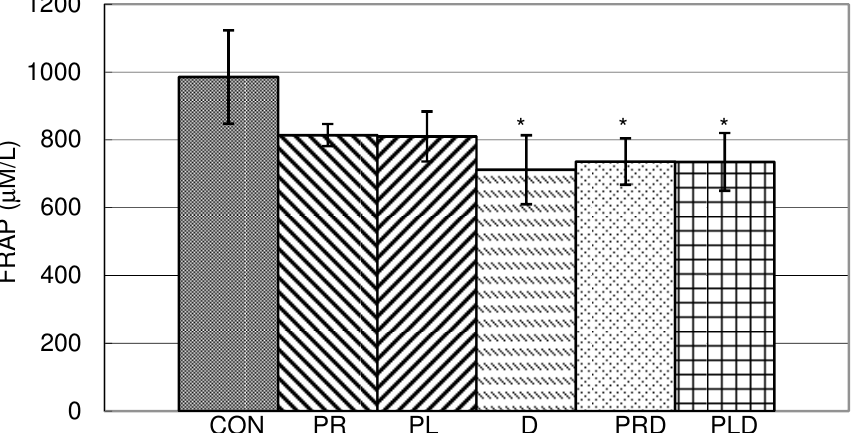
Figure 6. Effects of doxorubicin, parsley leaf and root juices and their combination on FRAP antioxidant capacities in hemolysate. t-test, n =  6; compared to CON group: * p < 0.05, compared to D group: a p <